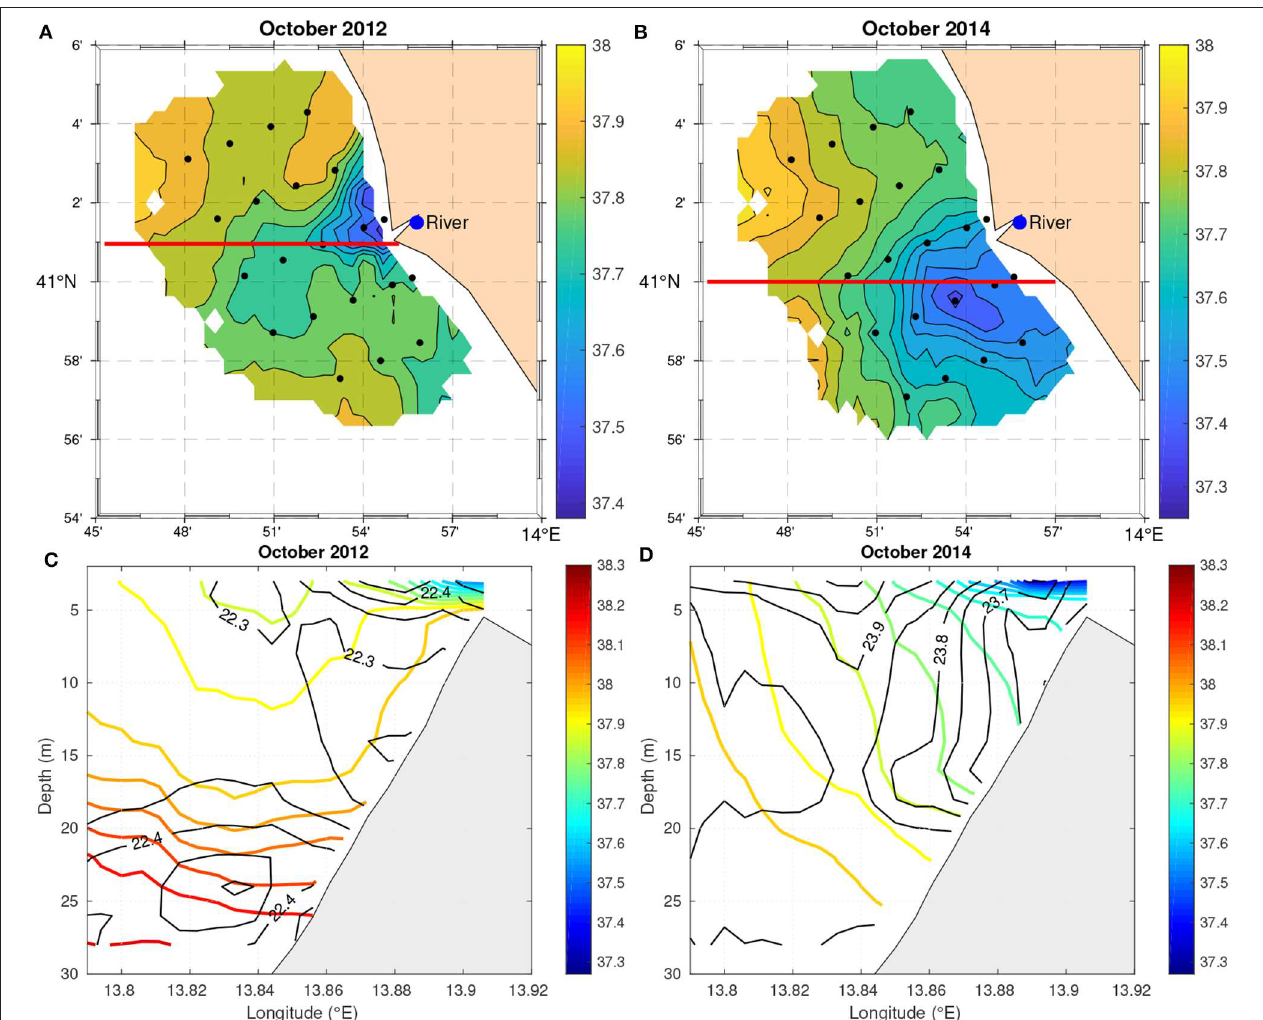
FIGURE 8 | OA maps of salinity ( g kg − 1 ) at 3 m (A,B) in October 2012 (left panel) and October 2014 (right panel). The fields are not plotted where the OA expected error exceeds 20 % . The contour interval is 0.1 g kg − 1 . Dots indicate location of stations. In (C,D) , the vertical isolines of temperature (in black, contour interval 0.1 ◦ C in C and 0.05 ◦ C in D) and salinity (colored, contour interval 0.2 g kg − 1 ) are shown along the 41 ◦ 1’N and 41 ◦ N parallels (red lines), respectively.